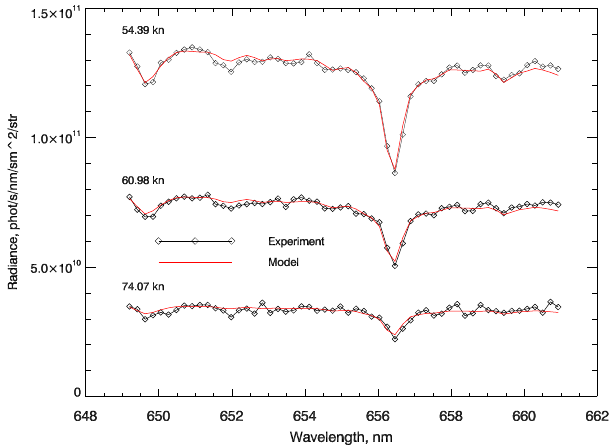
Figure 10. Fit of the multiplicative and additive radiation compo- nent around the H α line at 656nm.